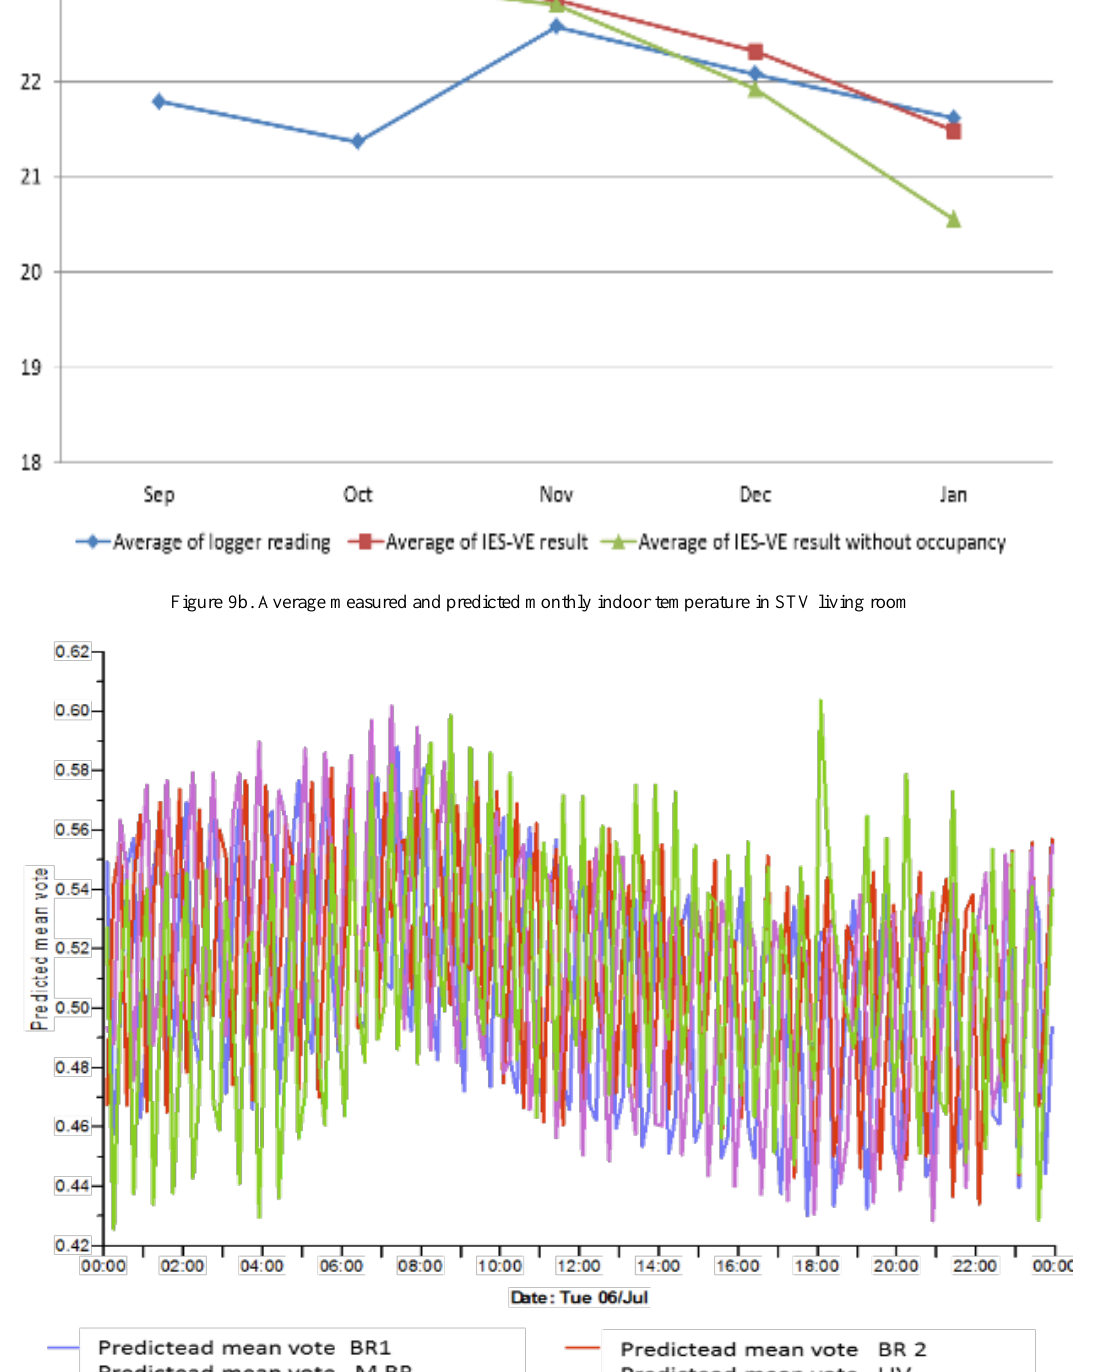
Figure 10a. PMV during the hottest day